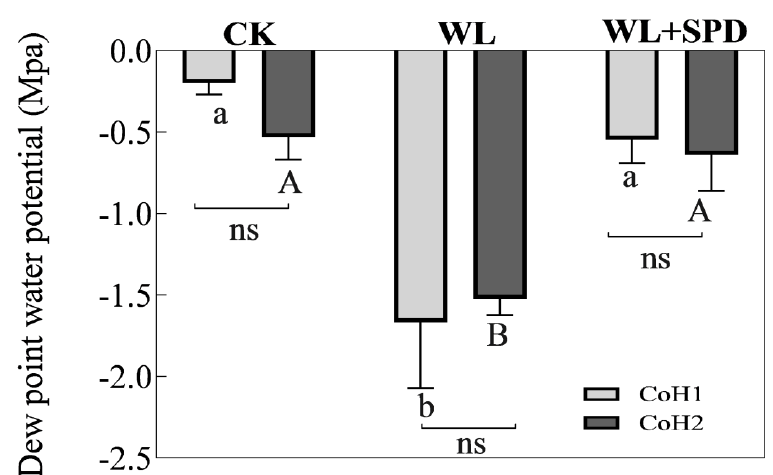
Figure 2. Dew point water potential variations in C. oleifera seedlings under WL exposed to SPD. The bars on the top show SE (n = 5), and different lowercases and uppercases indicate significant differences among CK, WL, and WL + SPD treatments within each species according to Tukey’s multiple comparison test, respectively ( p < 0.05). The signs such as * and ns in the figures concern the significance difference between the same treatment for CoH1 and CoH2 ( ns , Not significant). CK: control; WL: waterlogging; SPD: spermidine.